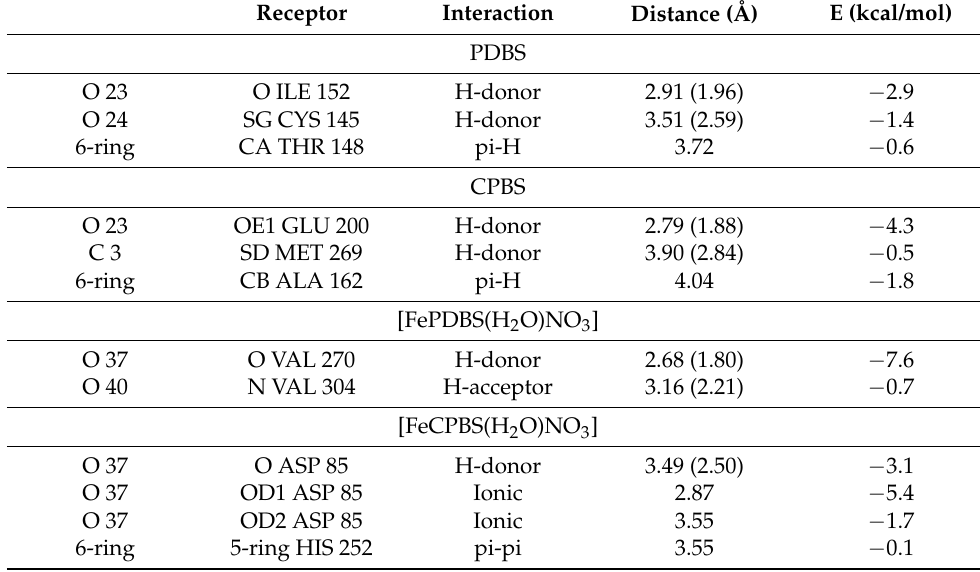
Table 8. The analysis of interaction data docking of PDBS, CPBS, [FePDBS(H 2 O)NO 3 ], and [FeCPBS(H 2 O)NO 3 ] with the active sites of the receptor of Escherichia coli protein (PDB ID: